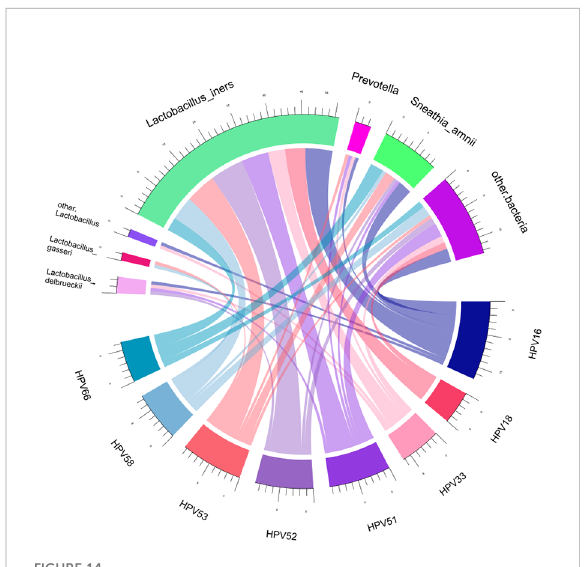
and dominant vaginal bacteria. The width of the strings (connecting lines) in the chord diagram shows the extent and proportion of the association between different HPV subtypes and dominant vaginal bacteria. The wider the width of the connecting lines, the higher the proportion. Different colors distinguish between different